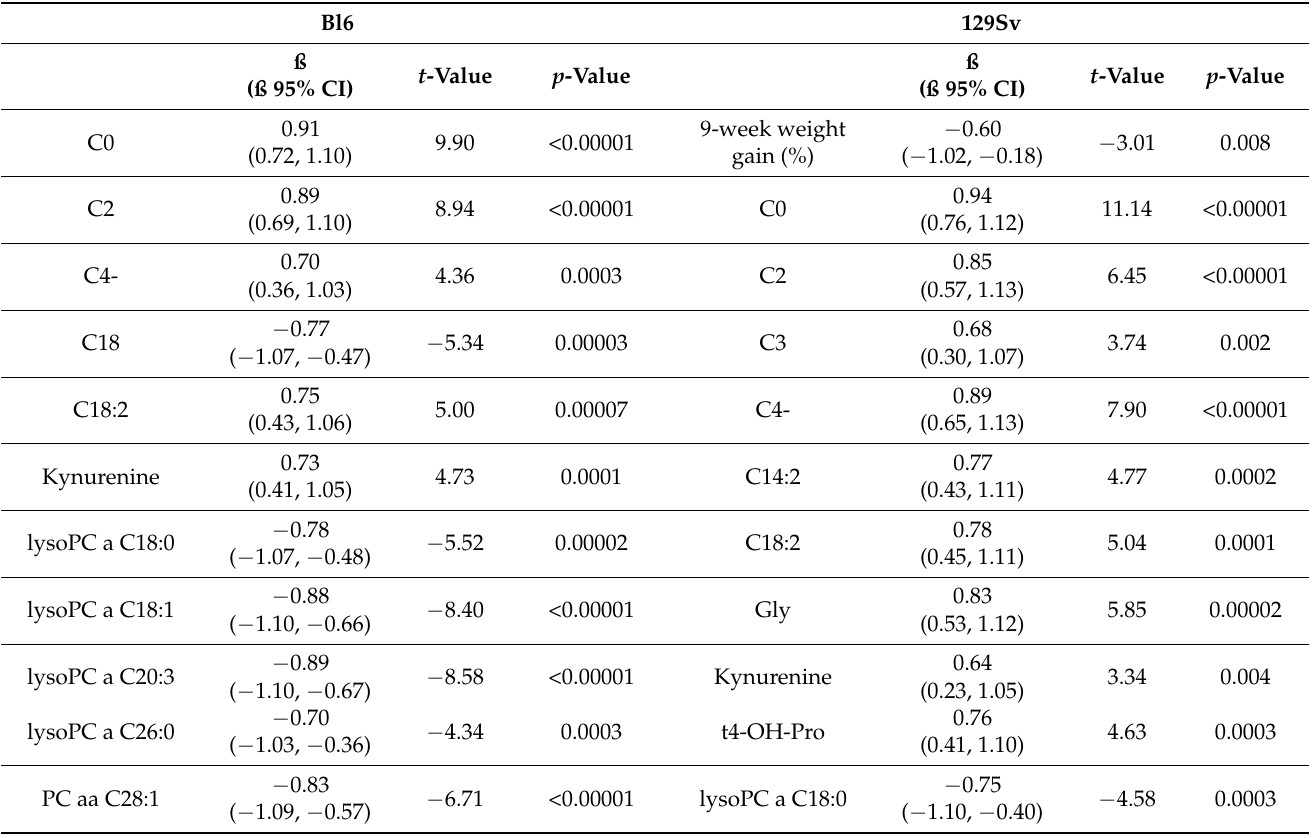
Table 2. Effect of HFD on metabolite levels among Bl6 and 129Sv mice. Bl6